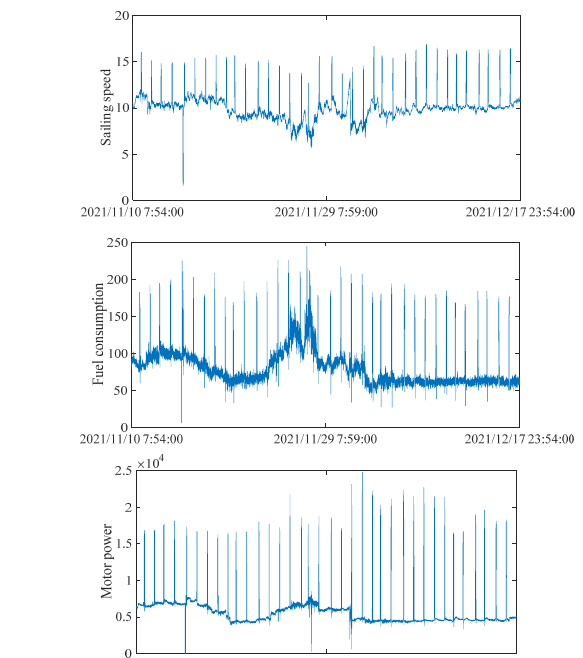
Figure 8. Experimental equipment used to verify the encryption scheme described in this study.